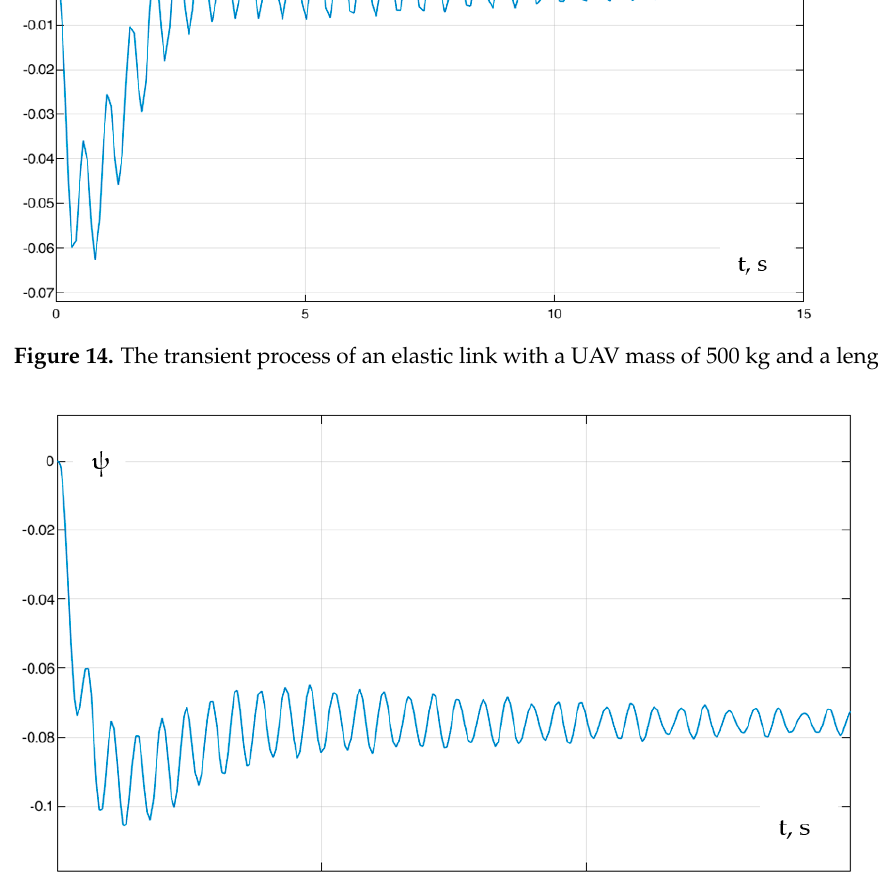
Figure 15. The transient process of an elastic link with a UAV mass of 1000 kg and a length of 10 m.